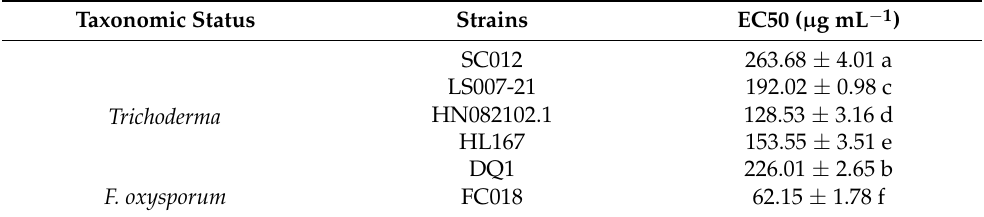
Table 1. Inhibition activities of hymexazol on Trichoderma and pathogen F. oxysporum